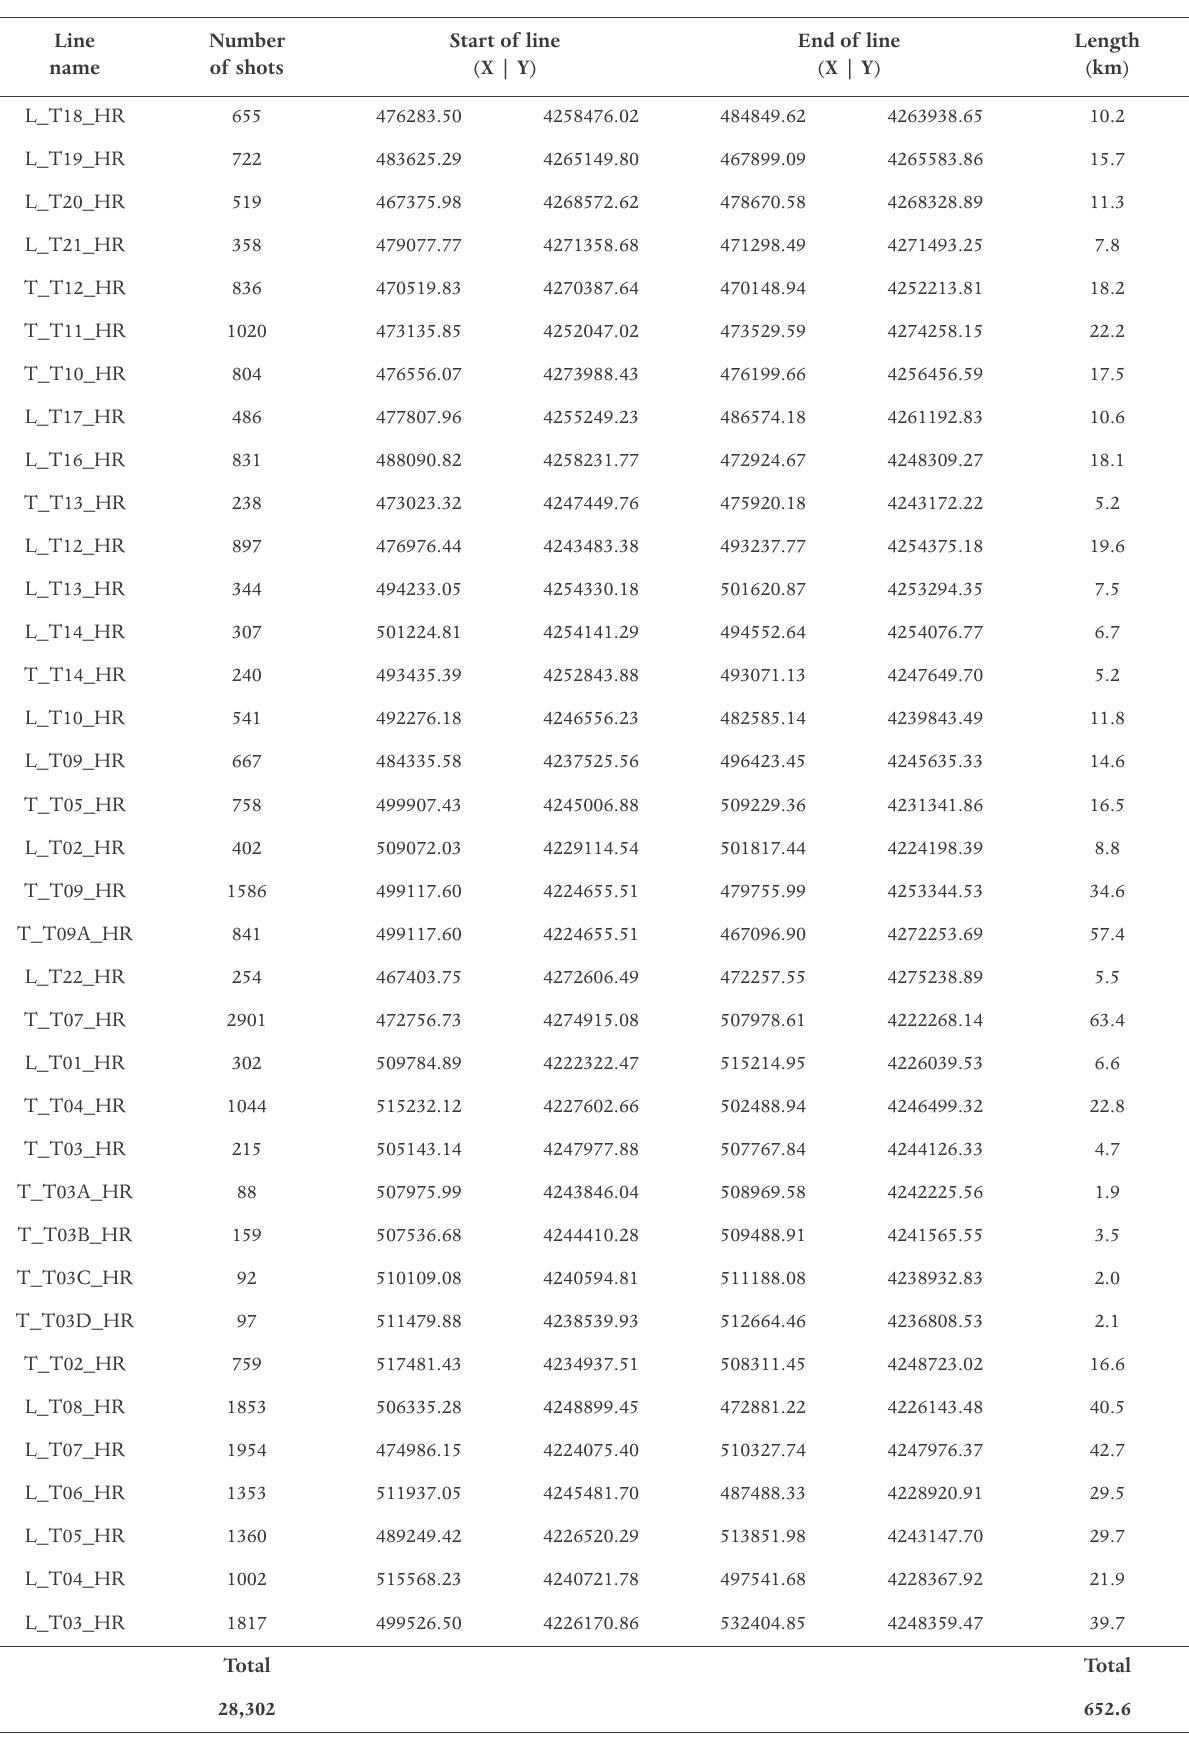
Table 2. Main characteristics of MCS lines acquired in the Tyrrhenian Sea area, during the TOMO-ETNA oceanographic cruise with the R/V “Aegaeo”. The coordinate are projected in UTM-WGS84, zone